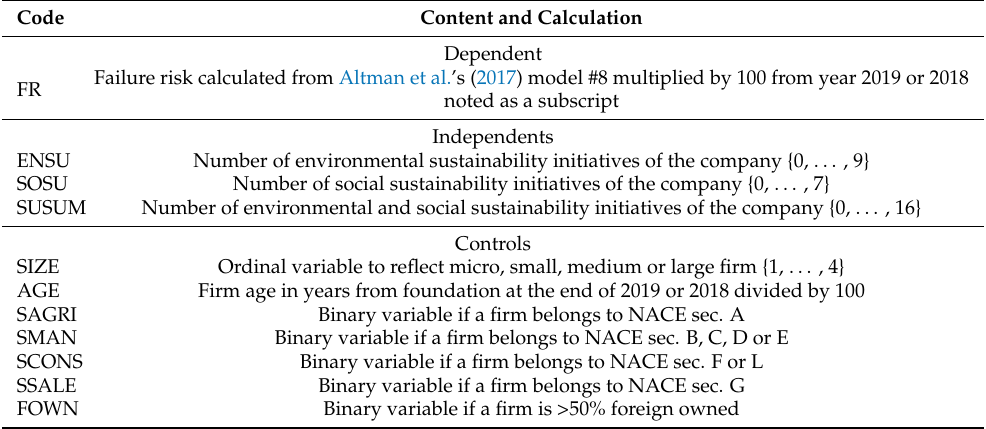
Table 3. Variables of the